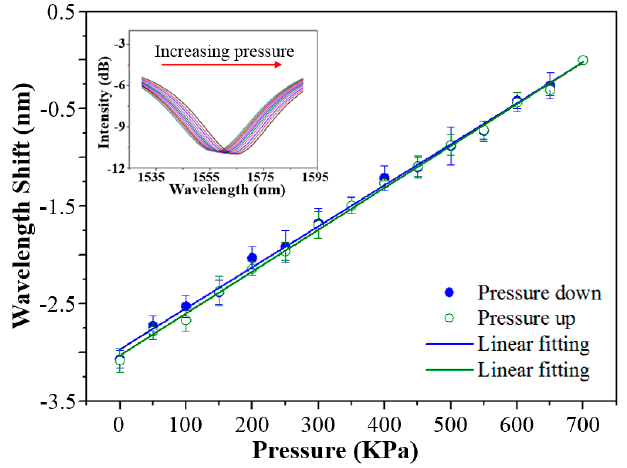
Figure 7. Response of a spectral dip of the optical fiber-tip sensor to the gas-pressure change of ambient environment. Inset shows the spectrum evolution of the tracked spectral dip.